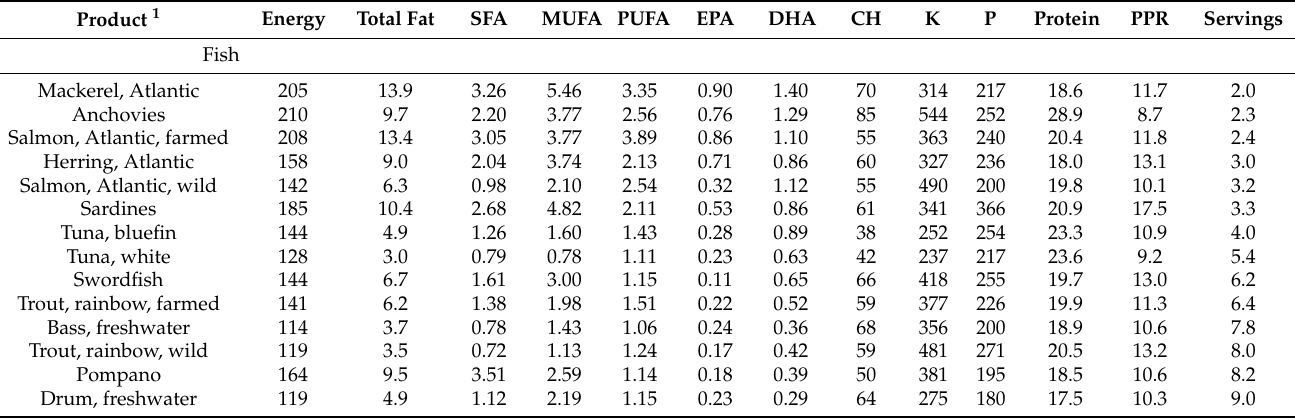
Table 2. Nutritional composition of fish, mollusks, crustaceans, and fish